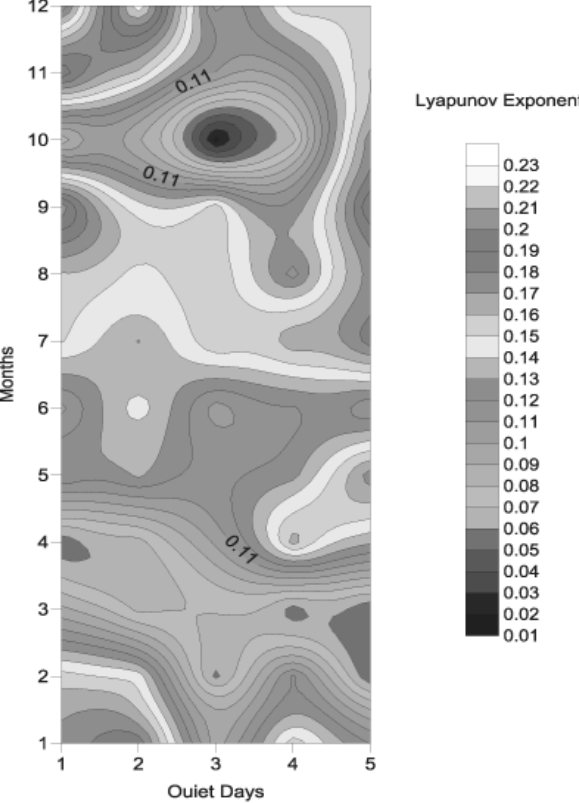
Fig. 15. Contour plot of Tsallis entropy at Enugu station for quiet days of